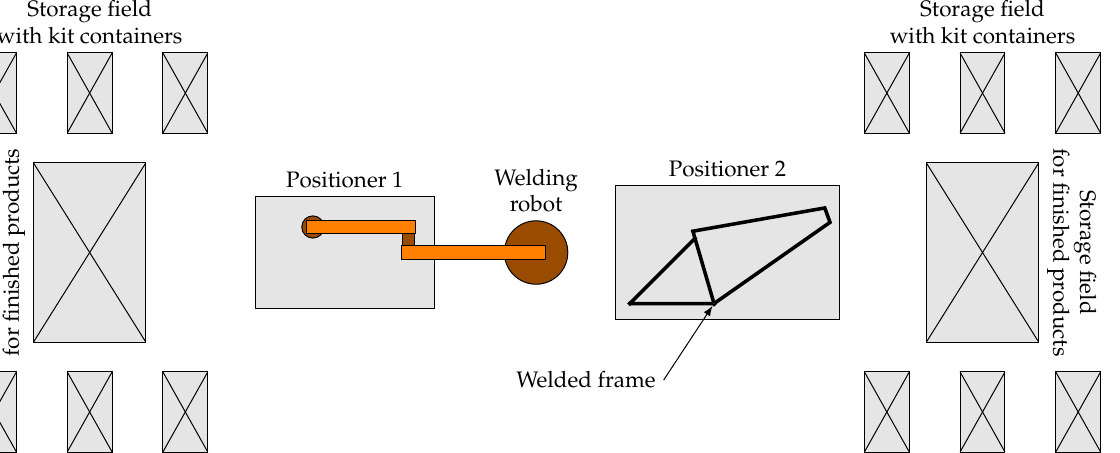
Figure 1. Robotic cell for aluminum bicycle frames